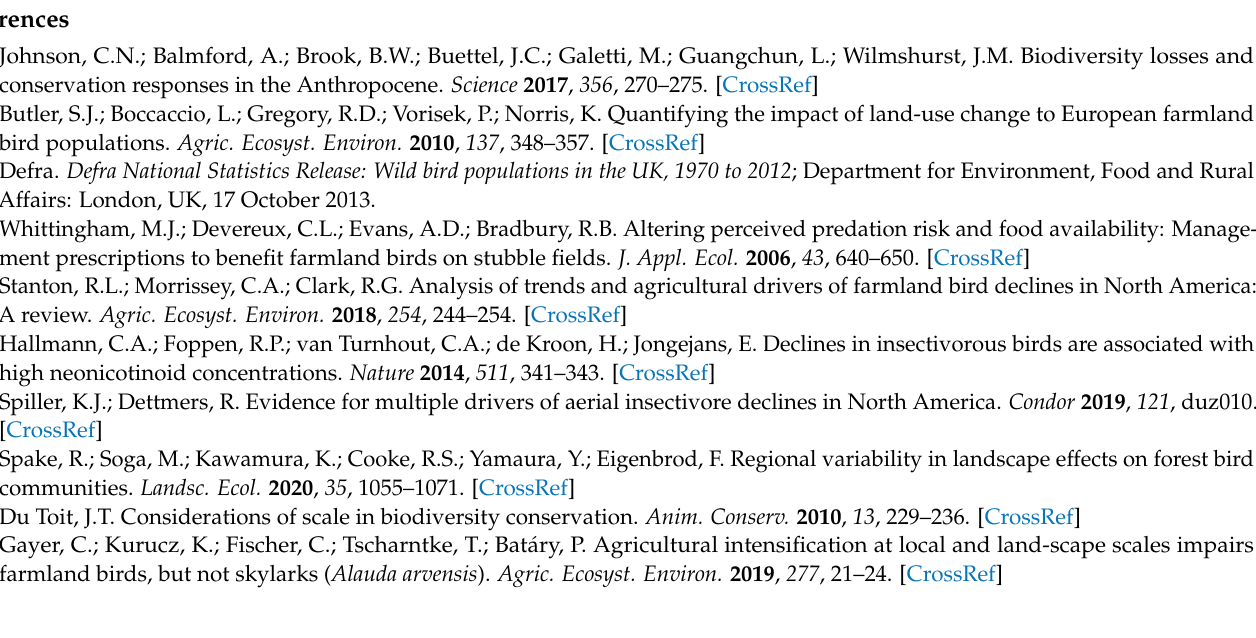
Figure S3: Example for a sample plot classified as arable plot (data base: habitat map of Brandenburg State (MLUL 2014); Table S1: Cropping area of the main crops within the bird sample plots and the rate of change between the two observational campaigns (cropping area in % of the total arable area, change in percentage points [%]; data source: the authors); Table S2: Classification of sample plots related to the dominant habitat type; Table S3: Assignment of representative bird species to habitat-specific guilds; Table S4: Overview of the 1-factorial variance analysis of the feature number of species dependent on factor observation year; Table S5: Overview of the 1-factorial variance analysis of the feature number of individual units dependent on factor observation year; Table S6: Change in numbers of species and individual recordings between the two observation campaigns; Table S7: Descriptive statistics of species occurrence and individual activity density during the observation campaigns at the plots; Table S8: Selected descriptive statistics of species occurrence at sample plots with respect to observation campaign and dominant habitat type; Table S9: Selected descriptive statistics of the sum of individual recordings at sample plots with respect to observation campaign and dominant habitat type; Table S10: Sum of individual recordings of arable land, grassland and forest bird guild species over all sample plots in the two observation campaigns; Table S11: Sum of individual recordings of bird individuals of the particular species of three bird guilds during the two observation campaigns; Table S12: Change in the landscape-wide occurrence and abundance of